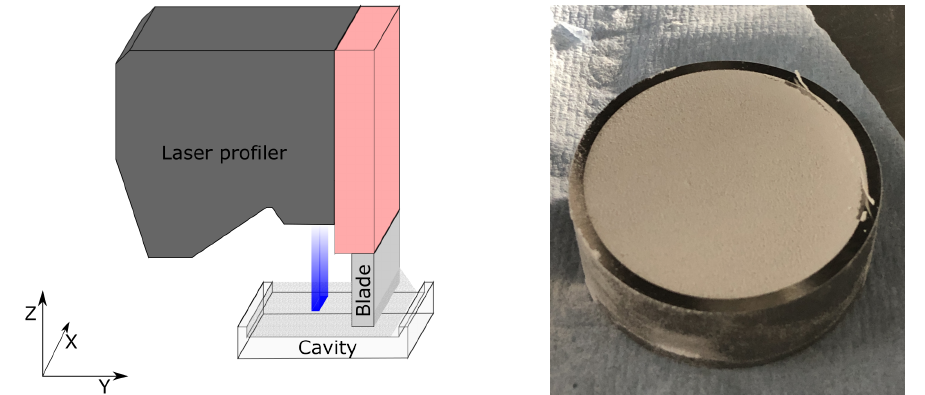
Figure 3. Schematic of the measuring setup ( left ) and filled cavity just before PLD measurement ( right